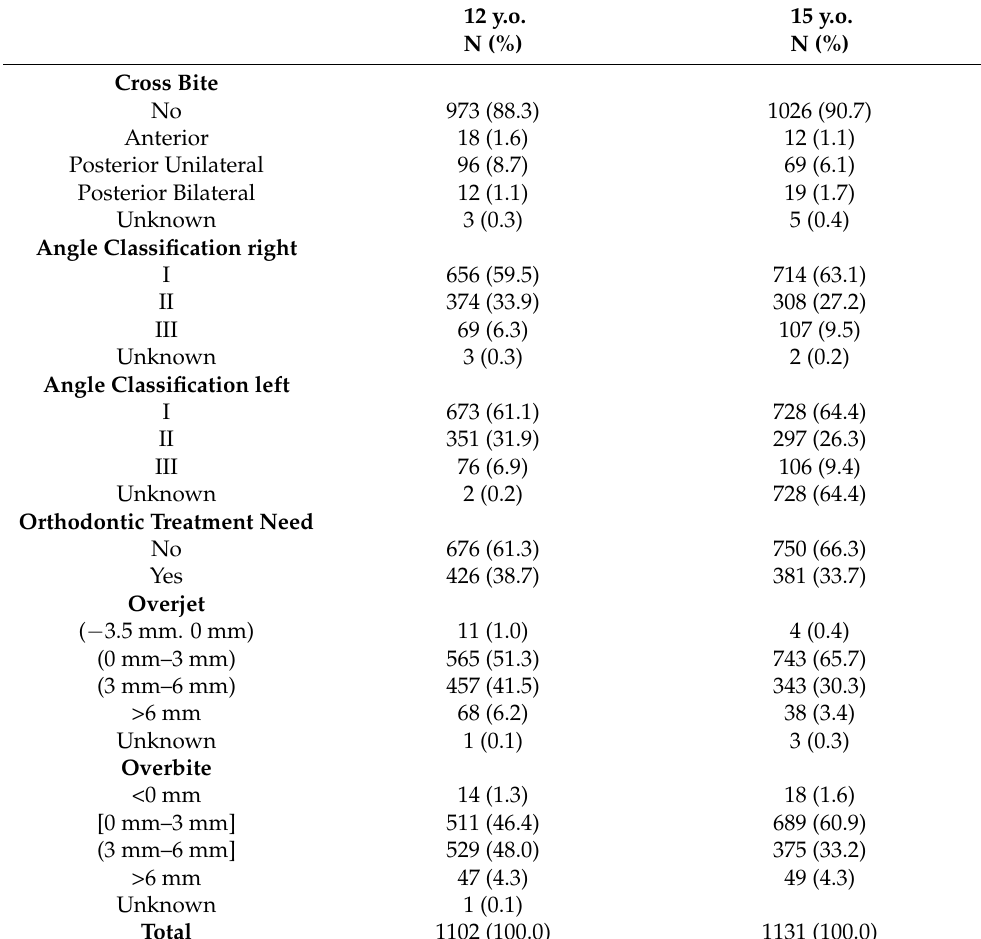
Table 5. Distribution of occlusal traits by age.